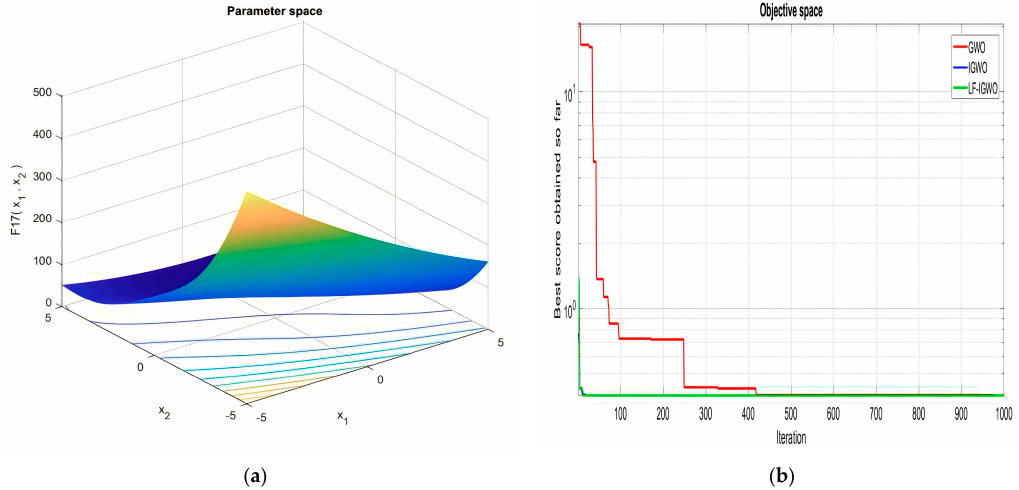
Figure 19. ( a ) Search space for fixed dimensional function F17 ( b ) Comparison of convergence curve for F17.